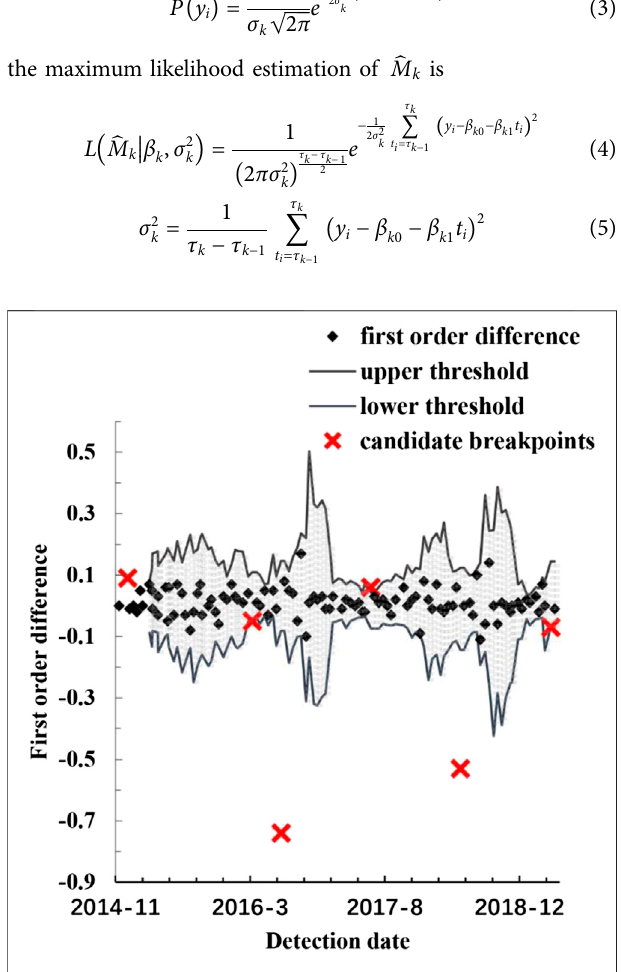
FIGURE 2 | A typical realization of the adaptive thresholding